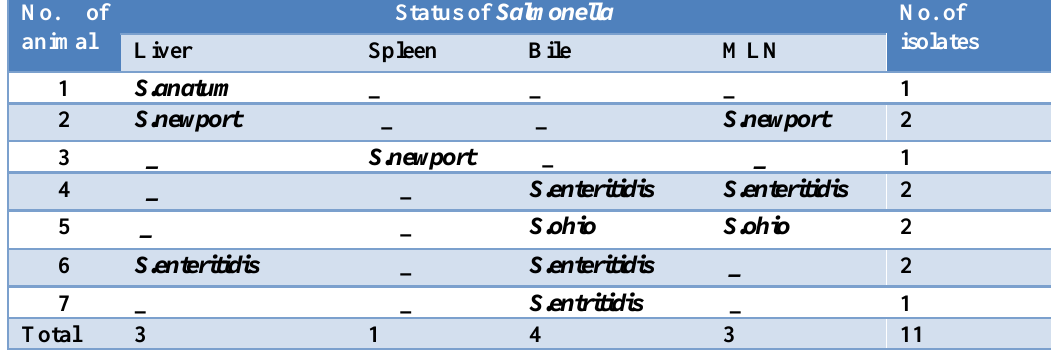
Table, 3: Number and distribution of Salmonella species in different organs No. of animal